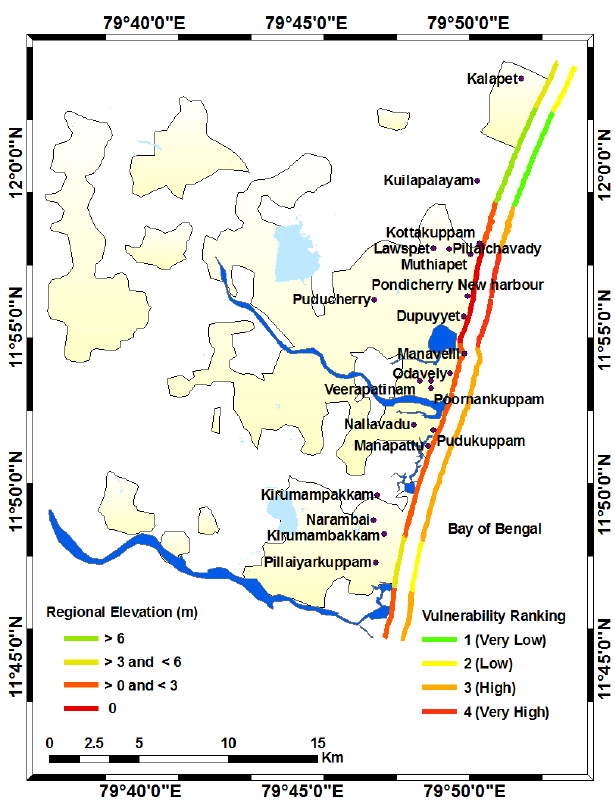
Fig. 5. Vulnerability ranking map of regional